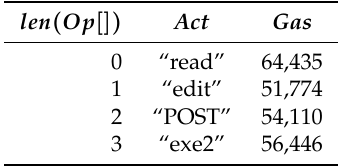
Table 5. Gas Used in BlendCAC’s createAction() ABI.